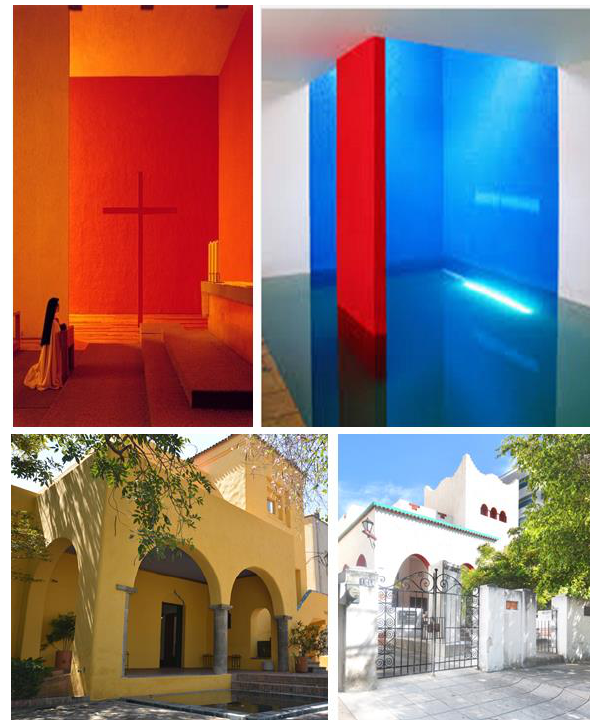
Fig.1 Examples of the Luis Barragán’s Architecural Production. Image source: authors elaboration.